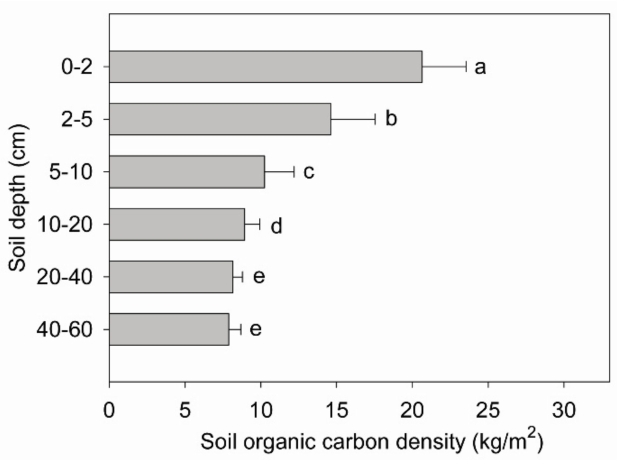
Figure 2. Vertical distribution of soil organic carbon along the lakeside of West Mauri